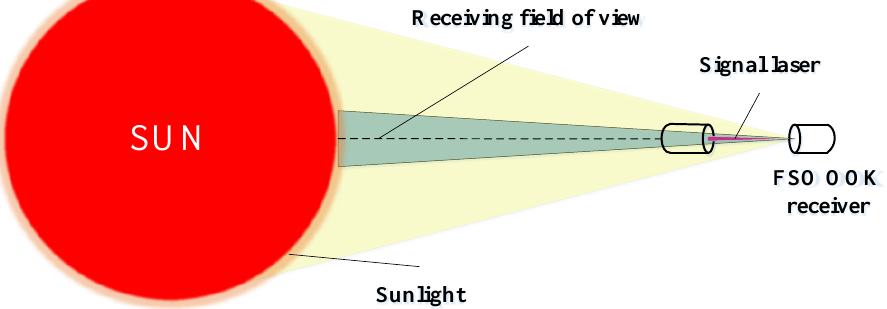
Figure 8. Diagram of direct sunlight on FSO receiver.